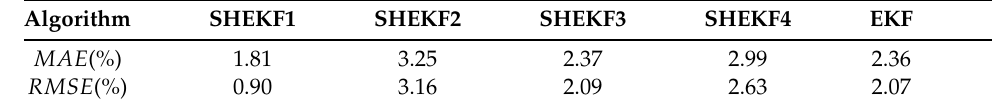
Figure 15. Comparison curves of algorithms and their error when running at 0 °C DST: ( a ) SOC, ( b ) Error. Table 6. RMSE and MAE under 0 °C DST condition.